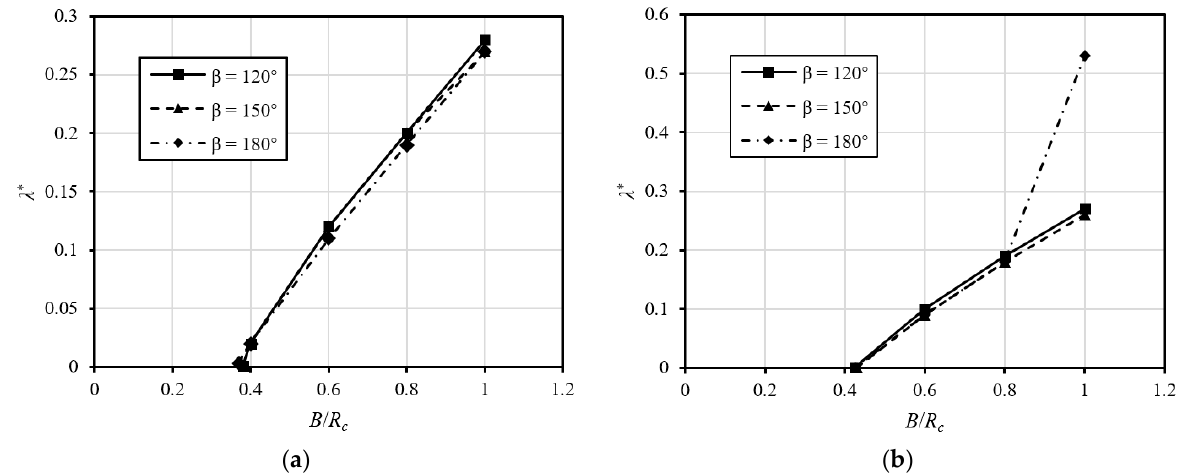
Figure 18. Variation of λ * against B / R c : ( a ) circular arch; ( b ) basket-handle arch. Table 5. Minimum statically stable B / R c.